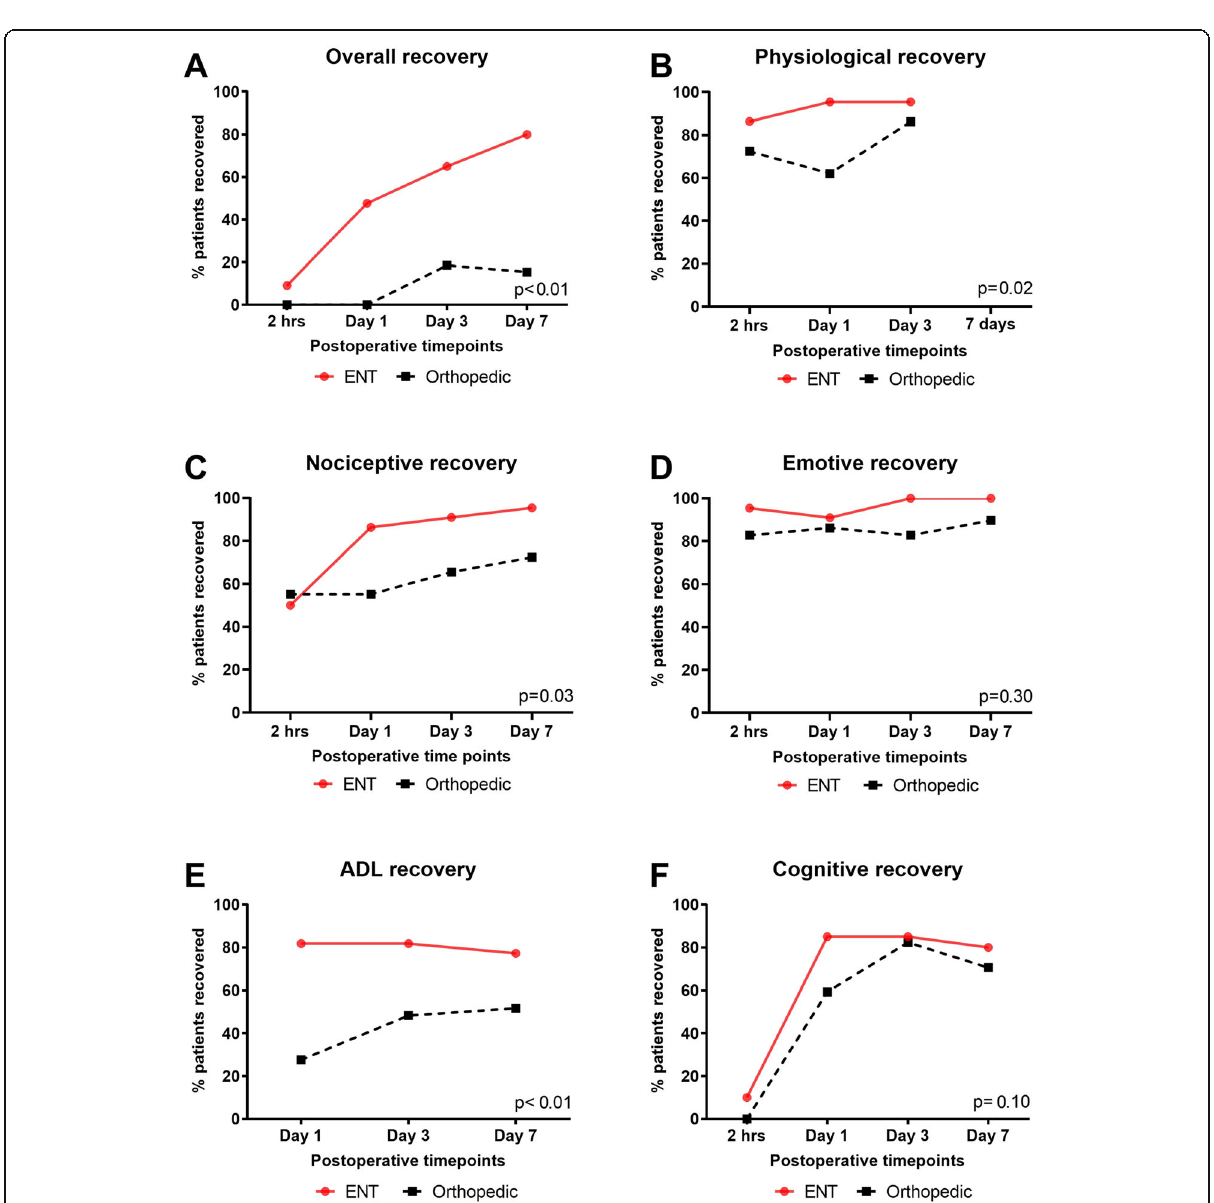
Fig. 2 Individual domain recovery of the Postoperative Quality of Recovery Scale from the Clinical study. a Overall recovery (recovery within all individual domains of the PostopQRS) within the two surgical cohorts at Miyazaki University Hospital. b Physiological domain recovery, c nociceptive domain recovery, d emotive domain recovery, e ADL domain recovery, and f cognitive domain recovery. All p values for group differences over time are presented by the GLMM and represent time by treatment